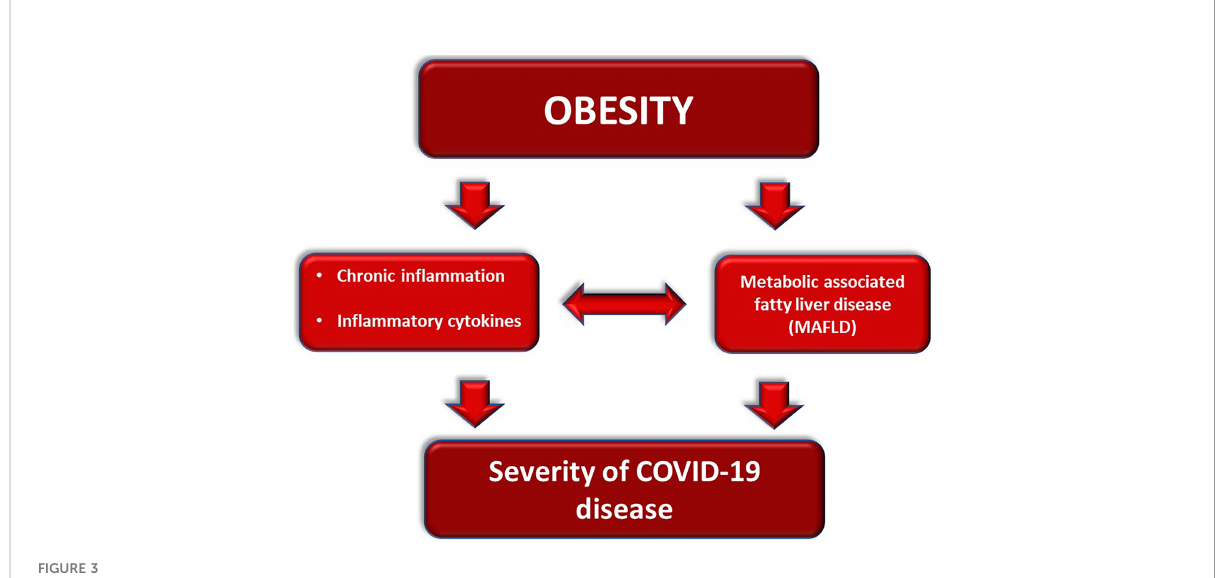
FIGURE 3 Obesity-related mechanisms worsening the course of